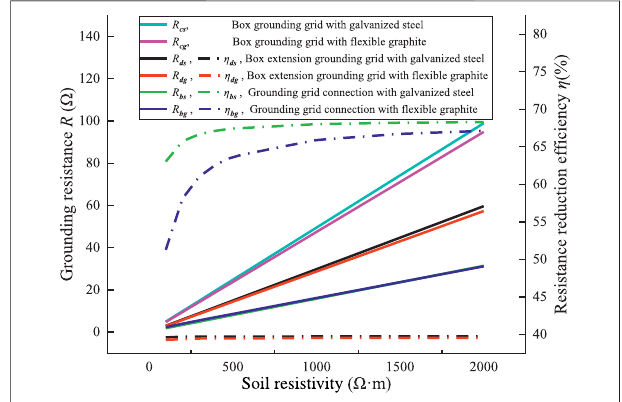
FIGURE 3 | Grounding resistance and resistance reduction ef fi ciency under different soil